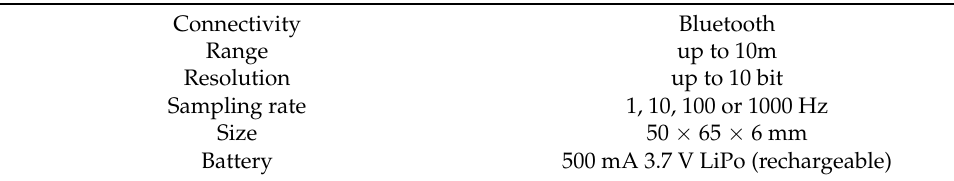
Table 2. Specifications of BITalino (r)evolution Plugged BT , the acquisition unit used in the experiment 1